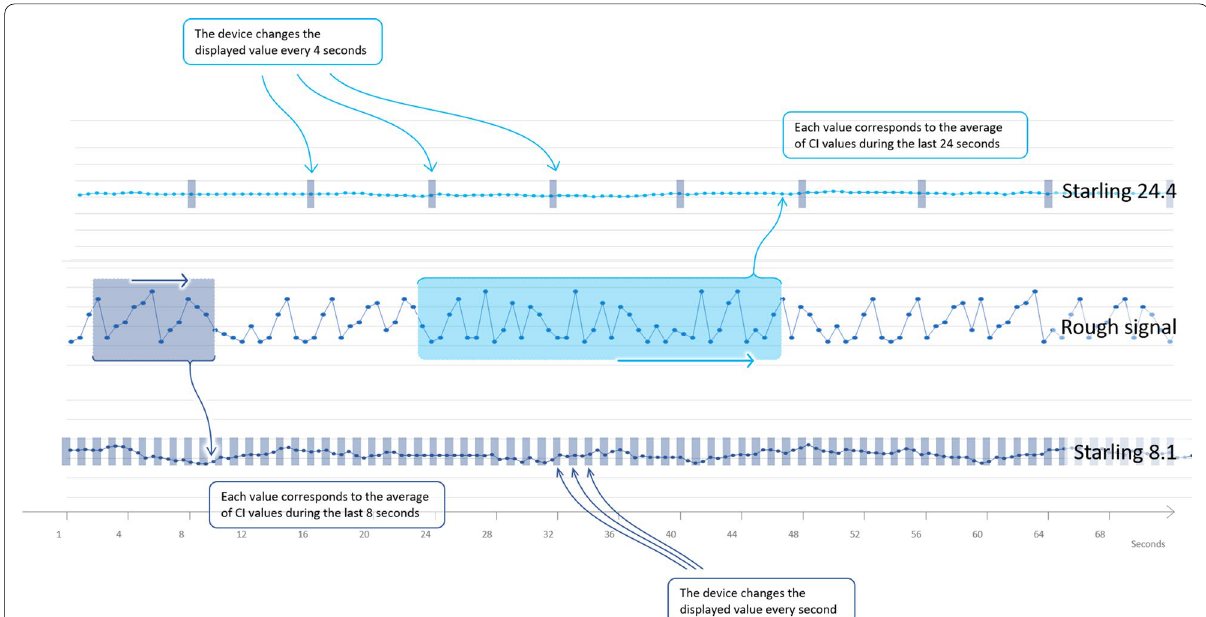
Fig. 1 Averaging and refresh times of both the commercial (Starling‑24.4—upper panel) and research (Starling‑8.1—lower panel) bioreactance devices. CI: cardiac index; Starling‑24.4: commercial version of the Starling device (averaging time 24 s, refresh time 4 s); Starling‑8.1: research Starling device (averaging time 8 s, refresh time one